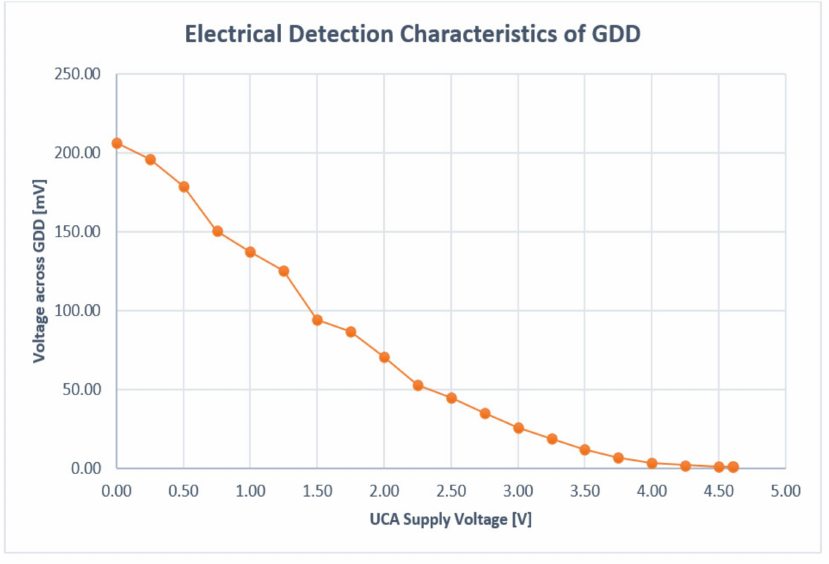
Figure 6. Voltage across GDD as a function of UCA voltage. The difference in LTF output with respect to the variation in the GDD bias current I DC is also measured as shown in Figure 7.